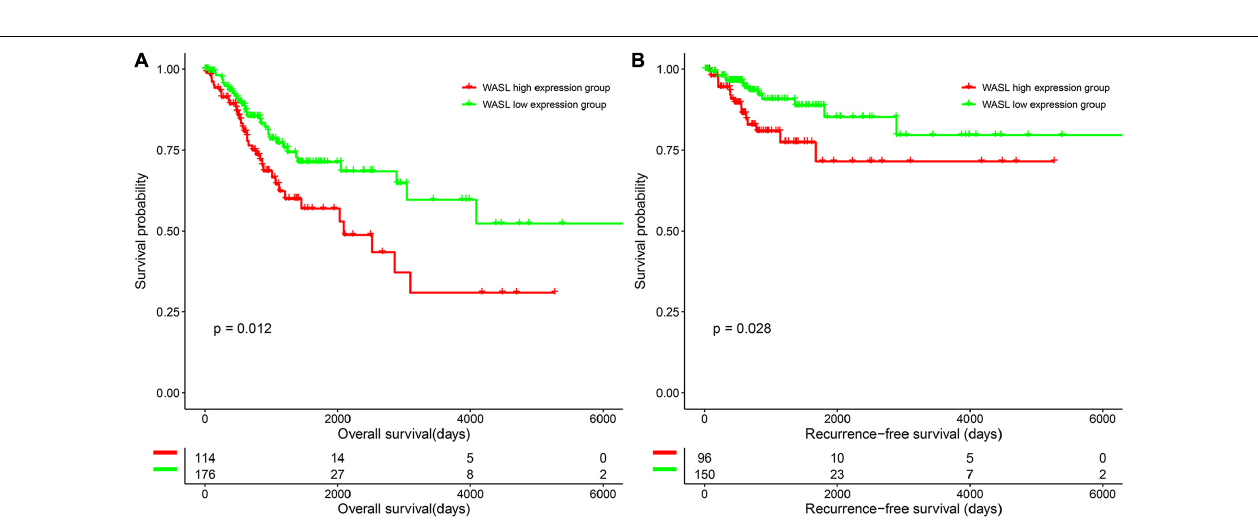
Frontiers in Cell and Developmental Biology |